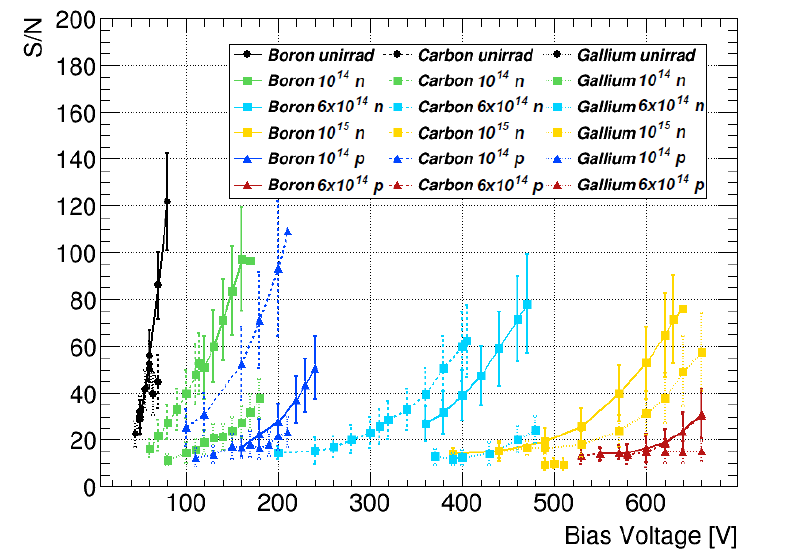
Figure A7. Signal-to-noise ratio as a function of the bias voltage for CNM LGADs irradiated up to a fluence of 10 15 n eq /cm 2 at − 30°C. The error bars are determined from propagation of